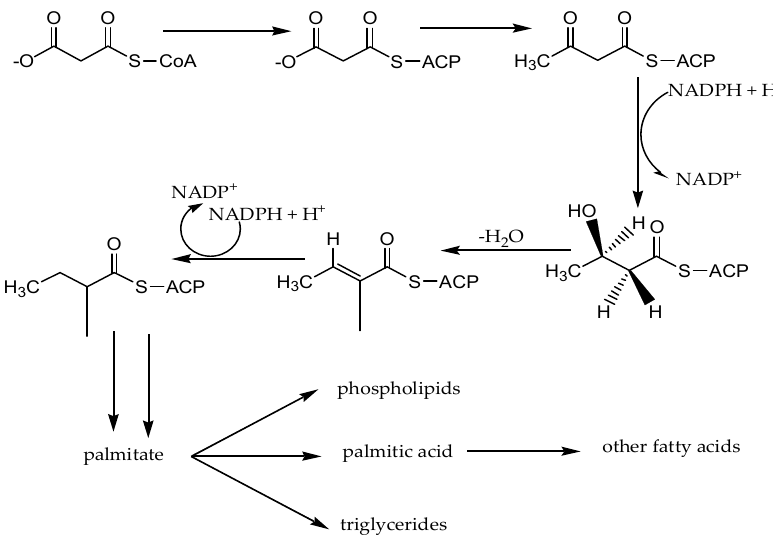
Figure 17. Fatty acid biosynthetic pathway in plants.